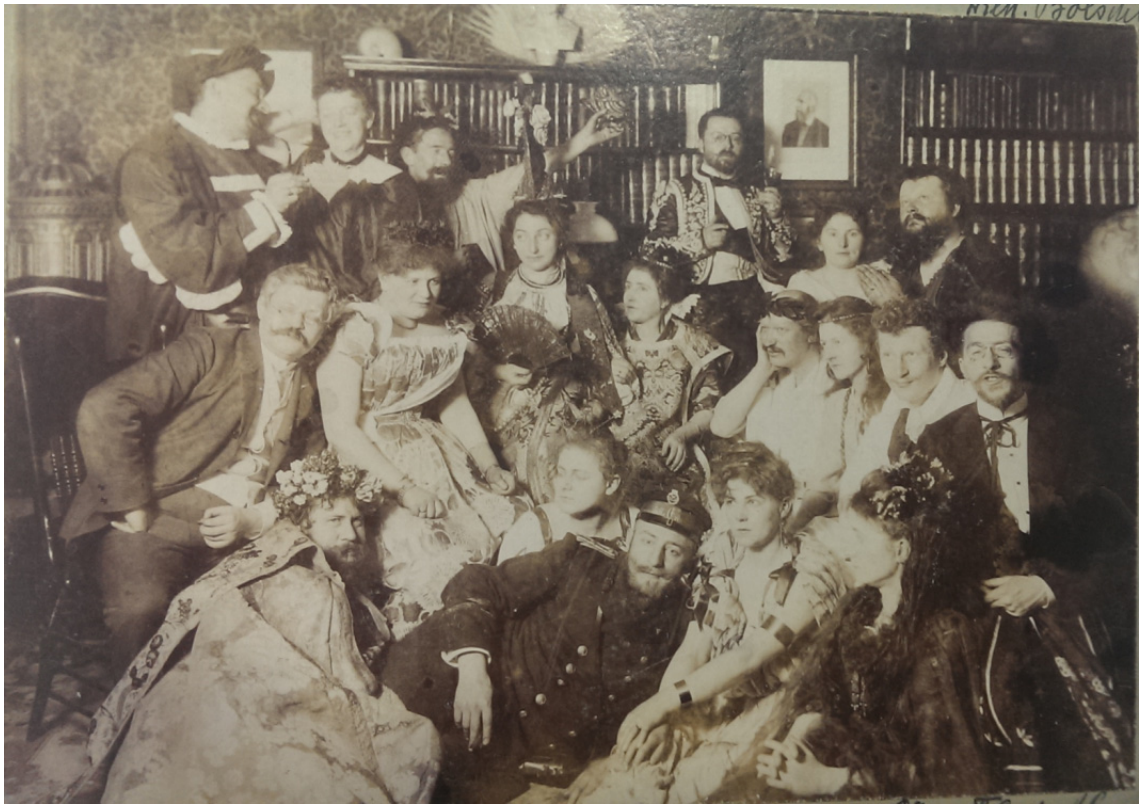
Figure 2. An undated image that seems to depict a costume party at the Uhland Street apartment. Courtesy of the Stadt- und Landesbibliothek Dortmund (StLB Dortmund, JHN Nr. 2827).